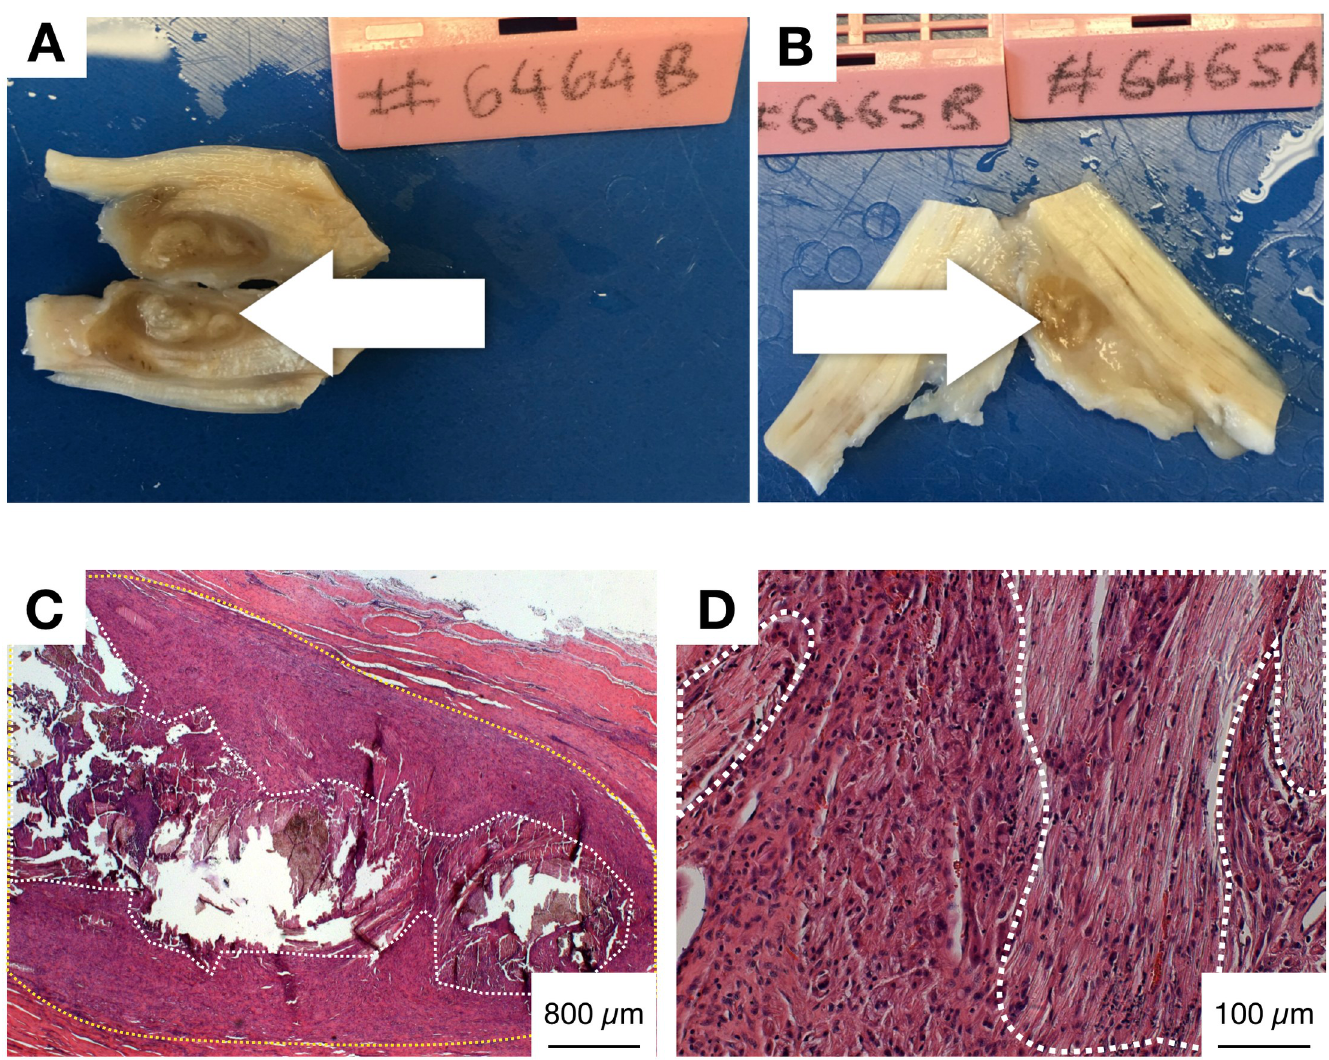
Fig 6. Explanted tendons with retained ES suture knots. A, B) Digital photographs showing retained ES suture knot (white arrows) adjacent to DDFT tendon, encapsulated by fibrous capsule. These were observed in two sheep, which both were active and did not demonstrate any lameness postoperatively. C) Low magnification (2.5X) bright field microscopy image of H&E stained tendon harvest sample from sheep 6464 showing retained degrading polymer (dotted white boundary), surrounded by area of highly cellular tissue (dotted yellow boundary). D) Higher magnification (20X) bright field microscopy image of the same sample as in C, showing the degrading ES suture material (dotted white boundary). Fibroblast-like cells seen in these areas were more aligned than in regions where the material was not visible (outside dotted white boundary).